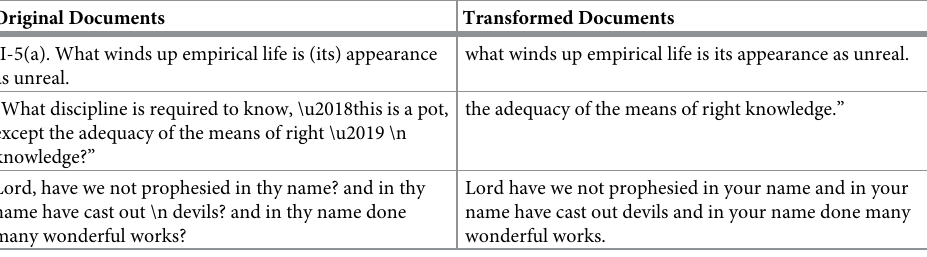
Table 2. Processed text after removing special characters and transforming archaic words into modern